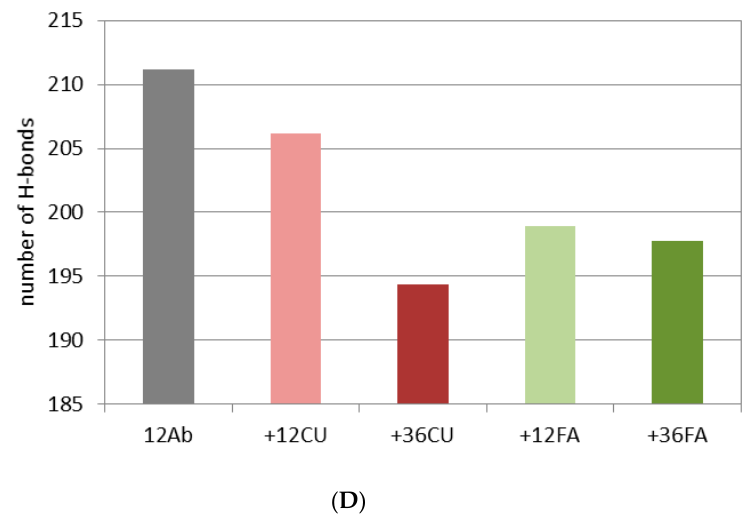
Figure 3. Root mean square fluctuations (RMSF) ( A ), solvent-accessible surface area (SASA) ( B ), number of non-native contacts ( C ), and number of H-bonds ( D ) averaged over 1000 frames (1000 ns) for 12 A β monomers (gray), 12 A β monomers and 12 CU molecules (pink), 12 A β monomers and 36 CU molecules (red), 12 A β monomers and 12 FA anions (light green), 12 A β monomers and 36 FA anions (dark green).